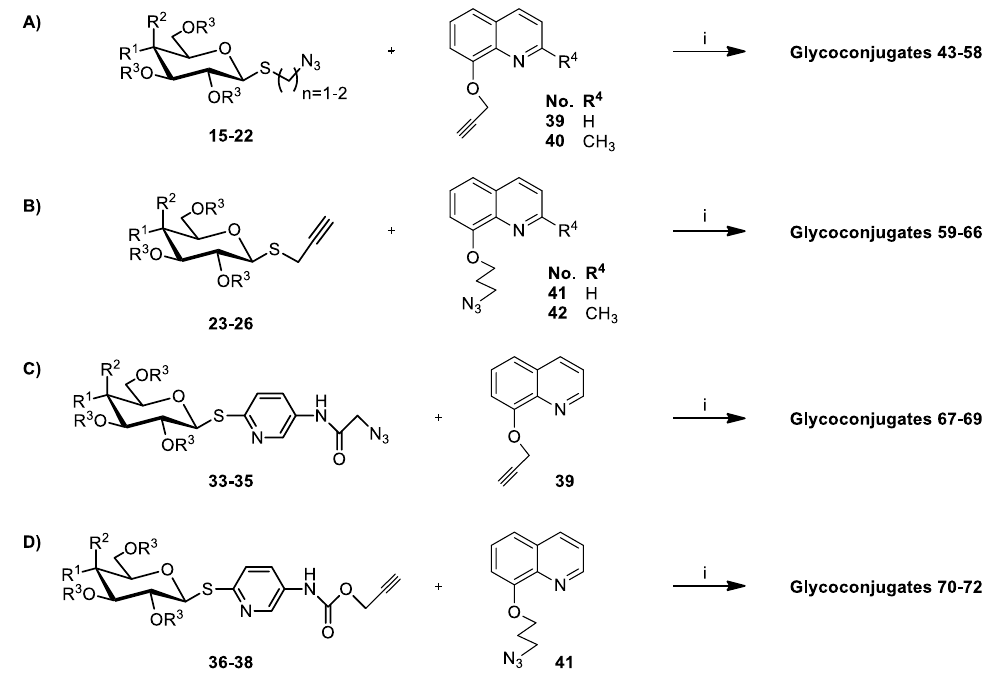
Figure 2. Structures and yields of obtained glycoconjugates 43 – 72 . 2.2. Cytotoxicity Studies In vitro cytotoxicity studies of the obtained building blocks and glycoconjugates were carried out on cell lines characterized by the high expression of GLUT transporters and the strongly changed glucose metabolism (strong Warburg effect) [10,49–51]. Based on this, colon cancer cell line (HCT- 116) and breast cancer cell line (MCF-7) were selected for the research. Compounds with a high